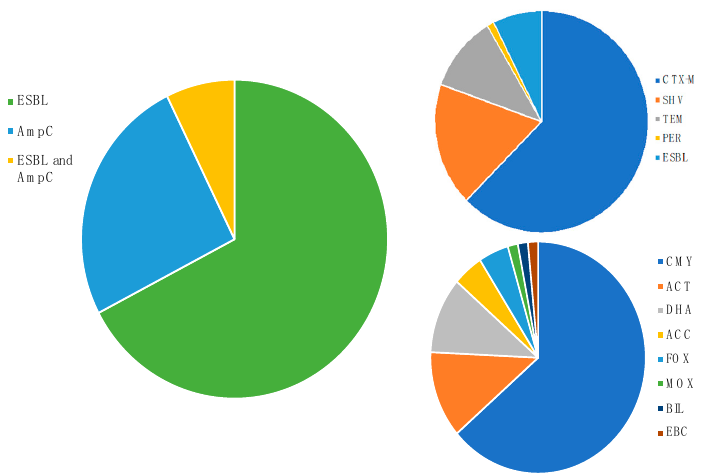
Figure 4. Proportion of publications by cephalosporinase (left), ESBL (top right) and AmpC beta-lactamase types (bottom right).